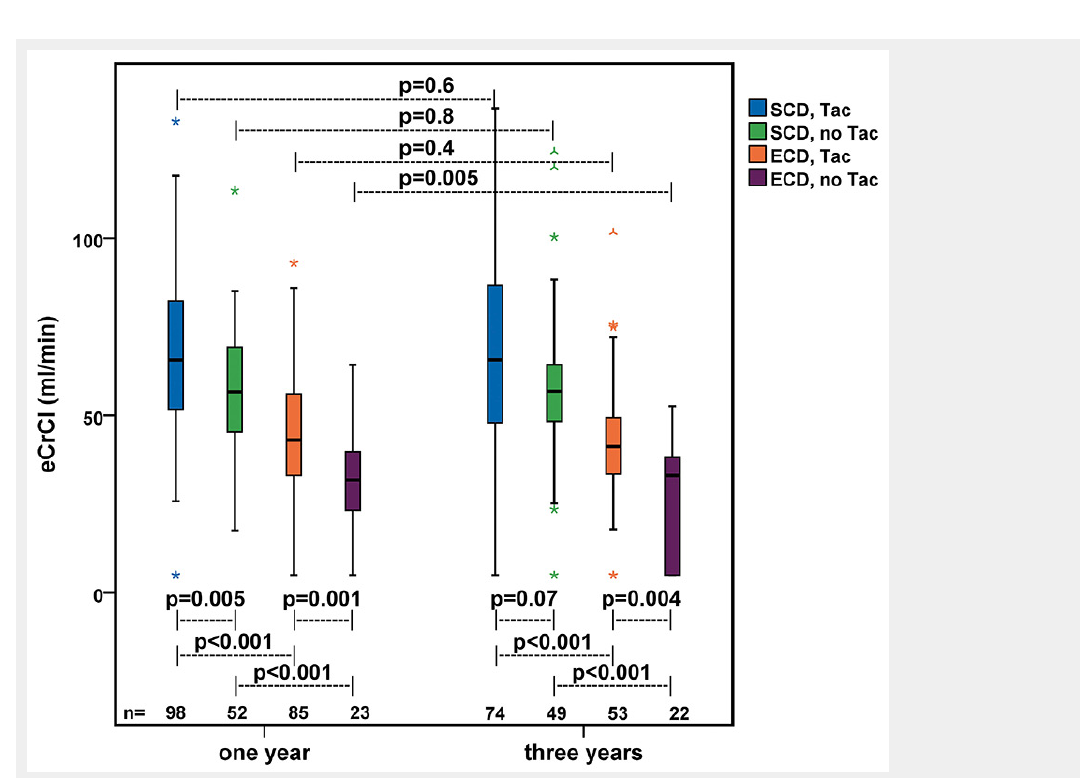
Figure 4 Renal function at one-year and three-year follow-up stratified by donor status and type of immunosuppression. An eCrCl of 5ml/min was assumed in patients who suffered from graft failure before the defined follow-up time points (one year n = 10 and three years n = 18); p-values of differences between groups were calculated by Mann-Whitney test; p-values of differences between one-year and three-year follow-up were calculated by Wilcoxon signed-rank test, considering only patients with values at one year and three year follow-up (n = 198). ECD = expanded-criteria donor; eCrCl = estimated creatinine clearance in accordance with the formula by Cockcroft and Gault [33]; SCD = standard-criteria donor; Tac =